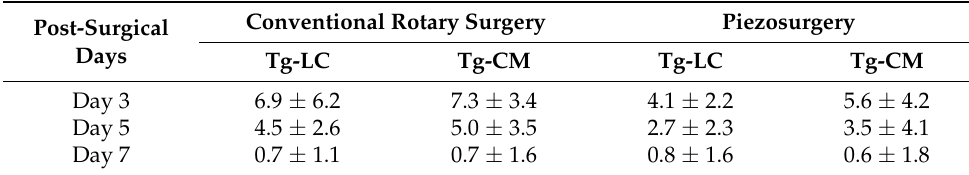
Table 2. Quantification of swelling (Tg-LC and Tg-CM) on the third, fifth and seventh postoperative days in both surgical techniques.